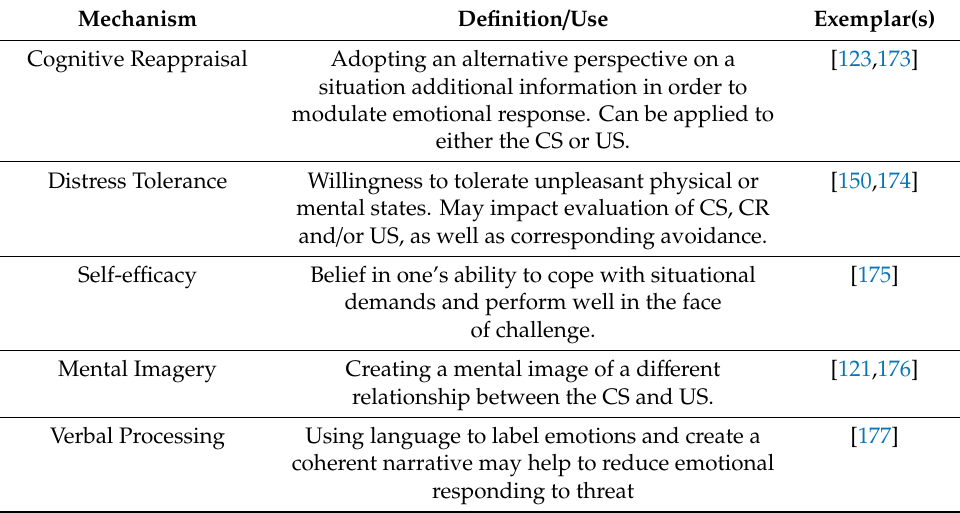
Table 2. Constructs and processes to apply to extinction